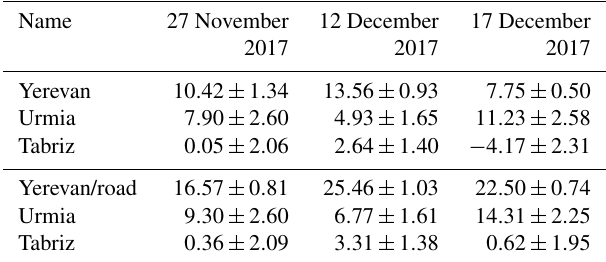
Table 2. Emissions (kgs − 1 ) estimated from the TROPOMI mea- surements shown in Fig. 7. First three rows: when fitting the emis- sion of Yerevan, Tabriz, and Urmia; last three rows: when fitting the emission of Tabriz, Urmia, and an assumed pollution along a traffic route near